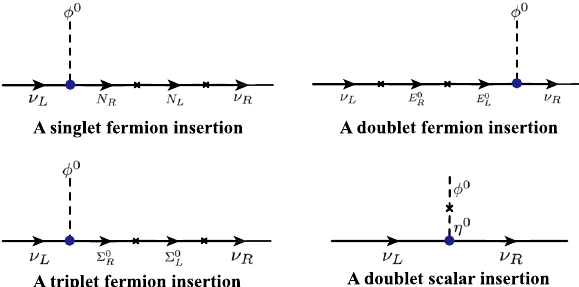
Fig. 7 Generating a two-loop realization of L 5 by linking X to X 6 in the diagram T3-iii-a depicted in Fig. 3 Fig. 8 Four different seesaw realizations of the Dirac neutrino mass operator L 4 with different new particle insertions, where N , E = ( E 0 , E − ) T , and (cid:10) = ((cid:10) + ,(cid:10) 0 ,(cid:10) − ) T denote a Dirac singlet, a Dirac doublet, and a Dirac triplet fermion respectively, whereas η = (η + ,η 0 ) T is a scalar doublet [88]